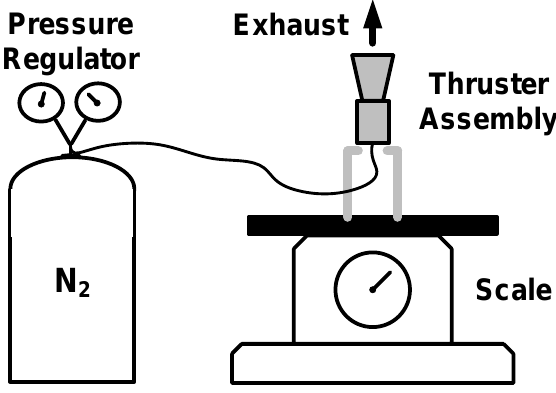
Figure 11. Experimental setup used to assess the thrust generated by the 16 thruster assemblies produced for the Adelis-SAMSON nano-satellites.